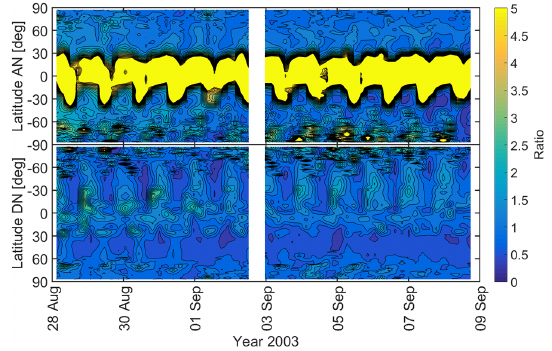
Figure 20. Electron density ratio (GITM / CHAMP) as a function of time and latitude for “case e” (LTAN = 7:38, LTDN = 19:38).